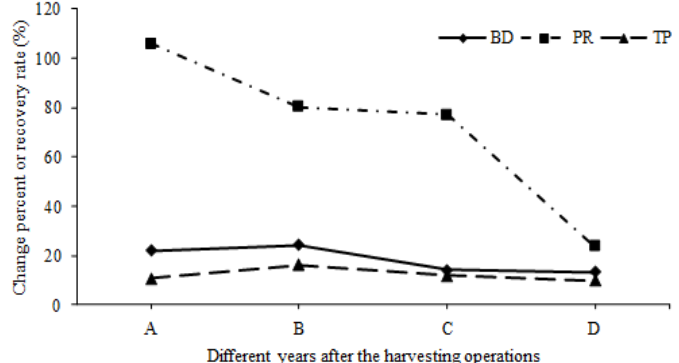
Figure 4. Soil properties’ recovery rate (change percent in different years after the skidding operations). A, B, C, and D represent, respectively, skid trails after a period of 5 years, 10 years, 15 years and 20 years.